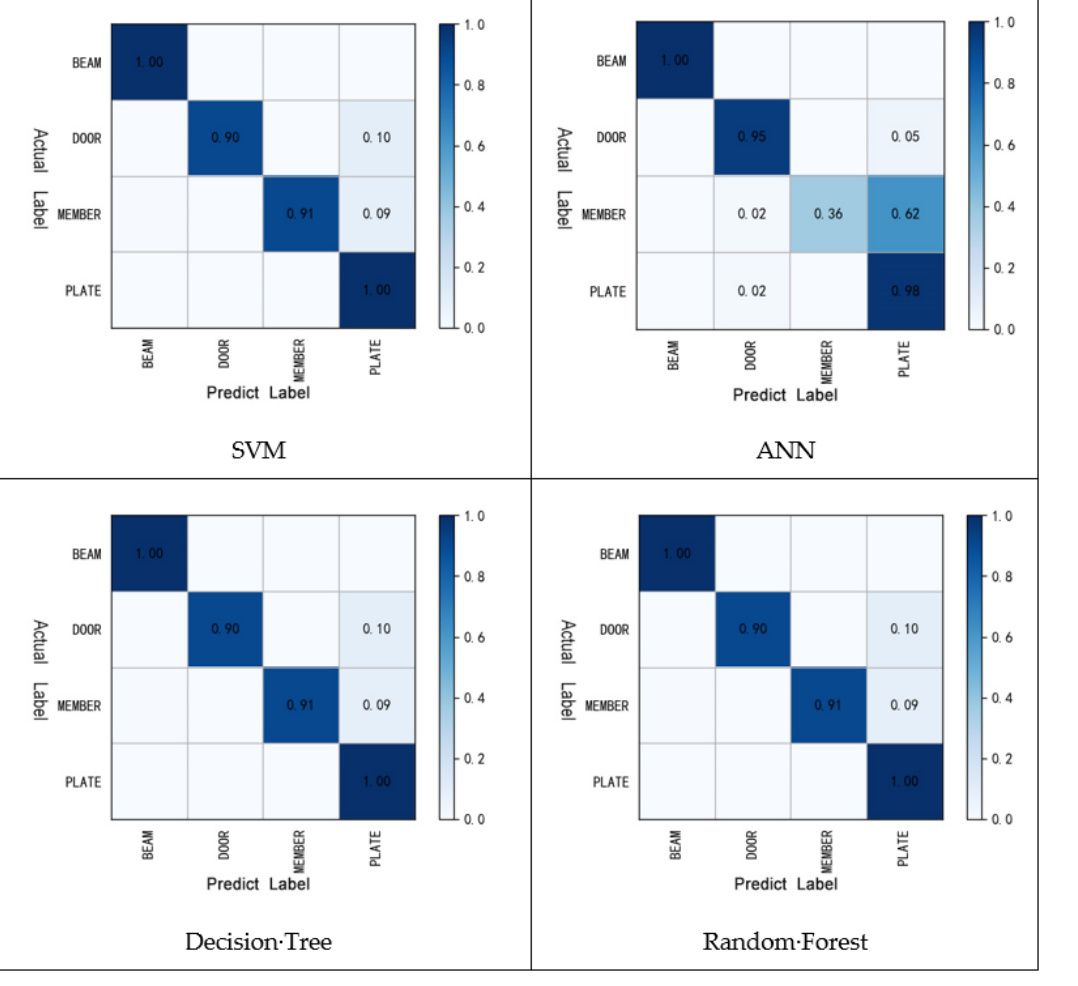
Figure 12. Confusion matrix about Data